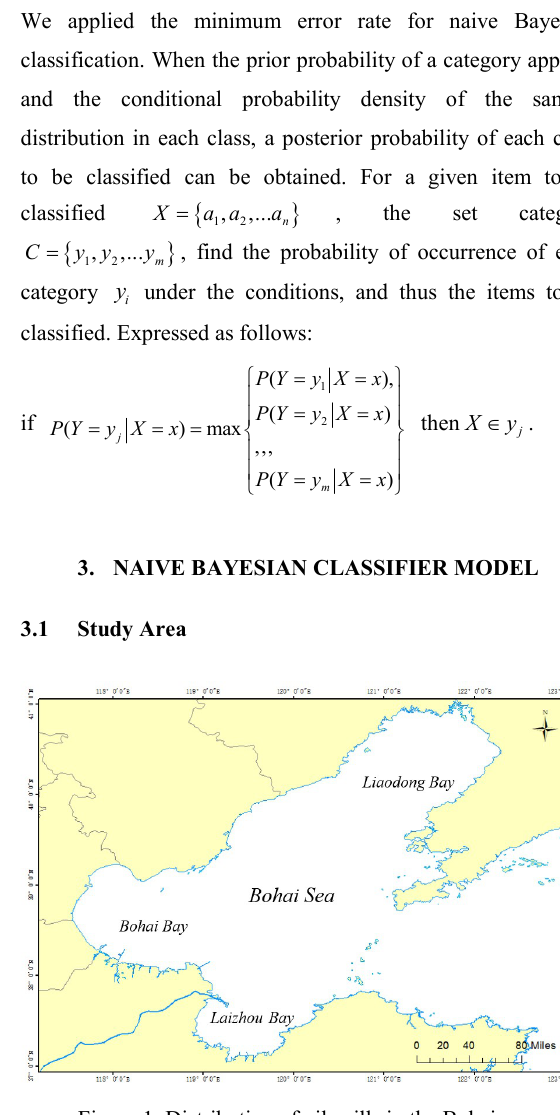
Bohai Sea consists of Liaodong Bay, Laizhou Bay, Bohai